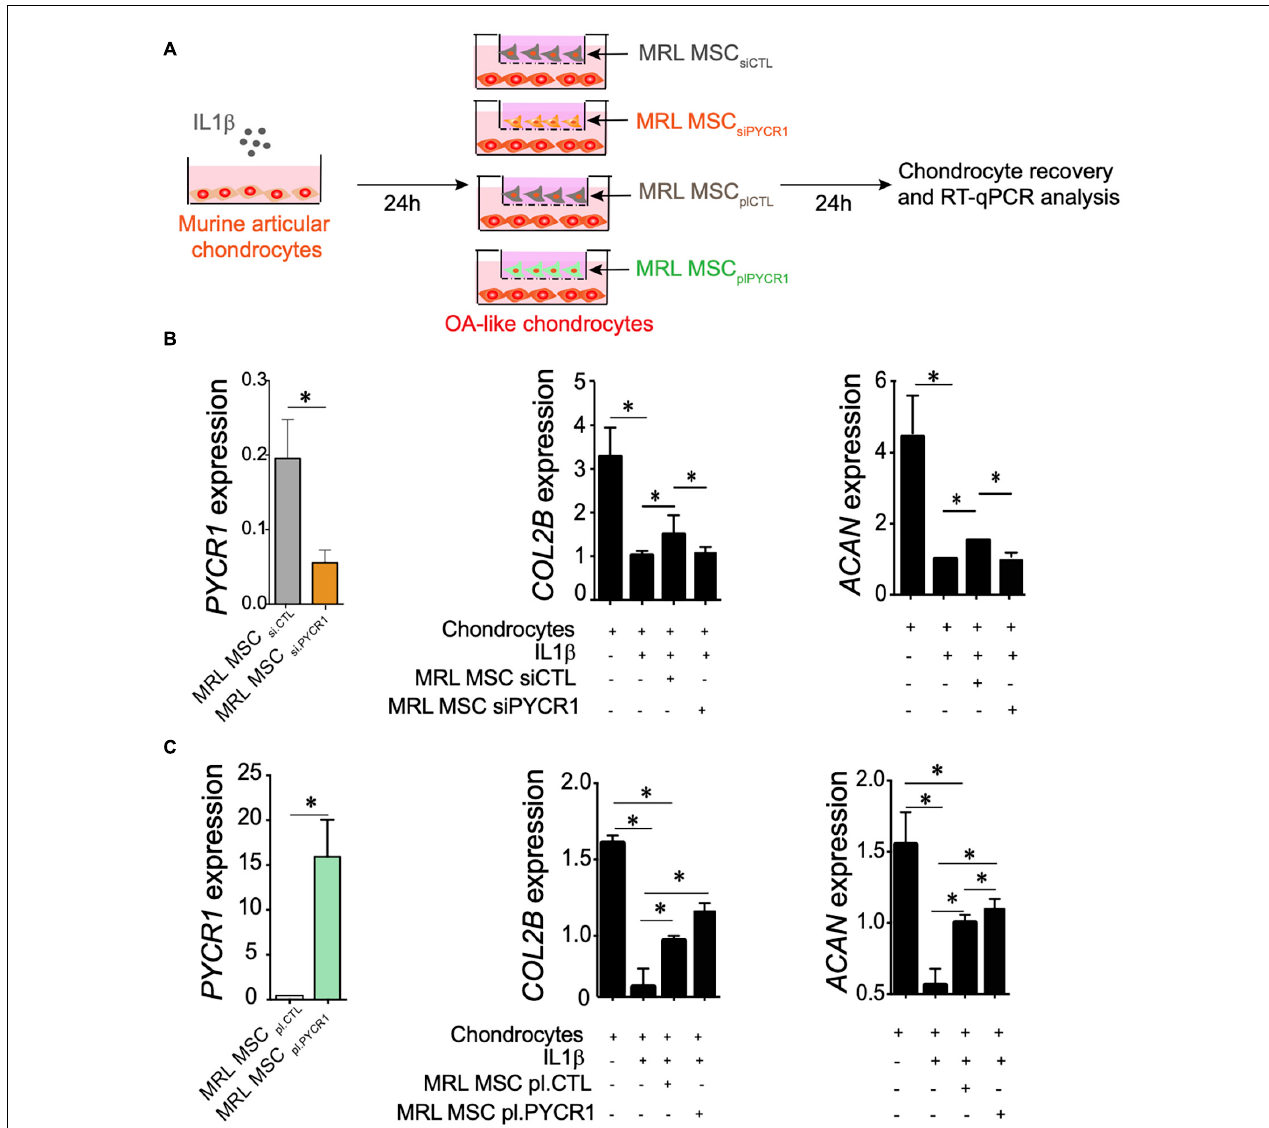
FIGURE 5 | Pycr1 regulates the chondroprotective abilities of MRL MSCs. (A) Scheme illustrating the different coculture conditions using chondrocytes with OA features induced by a 24-h incubation of freshly isolated chondrocytes with IL-1 β and MRL MSCs. MRL MSCs were either transfected with a control siRNA (MRL MSC siCTL ), a siRNA against Pycr1 (MRL MSC siPYCR1 ), an empty vector control (MRL MSC plCTL ), or a plasmid encoding Pycr1 (MRLMSC plPYCR1 ). IL-1 β -treated chondrocytes and MRL MSCs were cultured during 24 h before to be collected for RT-qPCR analysis. (B) RT-qPCR analysis of different chondrocyte markers, Col2B and Acan , in healthy chondrocytes and IL-1 β -treated chondrocytes cultured alone or with either MRL MSC siCTL or MRL MSC siPYCR1 . (C) RT-qPCR analysis of different chondrocyte markers, Col2B and Acan , in healthy chondrocytes and IL-1 β -treated chondrocytes cultured alone or with either MRL MSC plCTL or MRL MSC plPYCR1 . Results represent the mean ± SEM obtained with three biological replicates. Statistics: Mann–Whitney test, two-tailed. p -Values < 0.05 ( ∗ ). MRL, Murphy Roths Large; MSC, mesenchymal stem cell; OA,